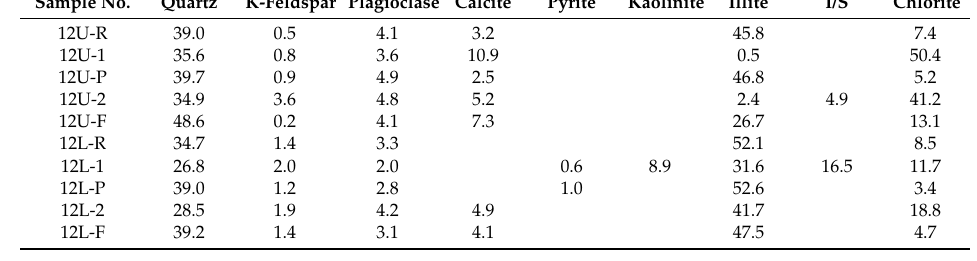
Table 5. Mineral compositions (%) of low-temperature ash, partings, roofs, and floors determined by XRD and Siroquant techniques.